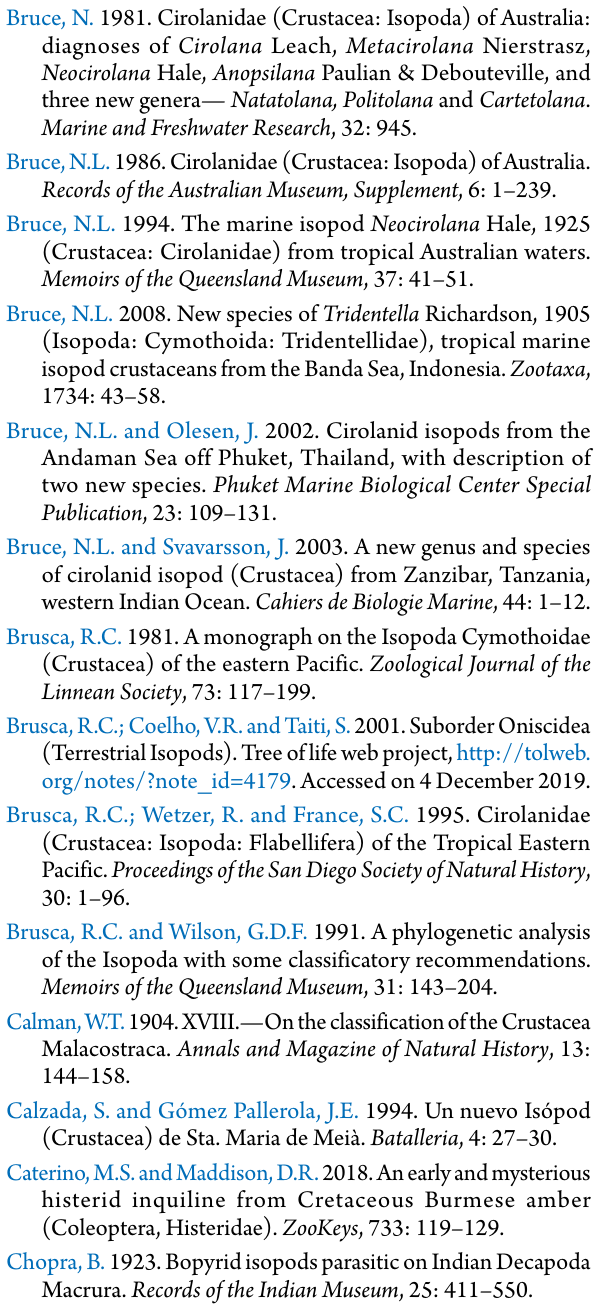
Supplementary file 8: Figure S6. Paratype of Electrolana madelineae sp. nov. (NHMW